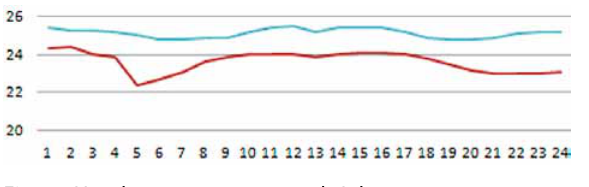
fig. 16. Hourly temperatures – 27th july Note: blue graph: recorded temperatures inside the hut; and brown graph: temperatures recorded outside the hut on 27 th